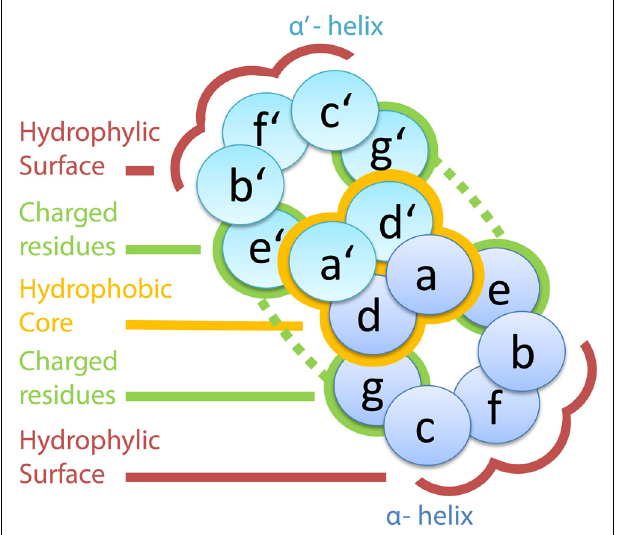
FIGURE 1 | Outline of a section through two a helices interacting via leucine zippers. The amino acids in positions a and d configure the hydrophobic core, which is indicated with the yellow halo. Charged residues in positions e and g generate electrostatic forces, represented by the dashed green lines.The hydrophilic surface is formed by the amino acids in positions b , c , and f .